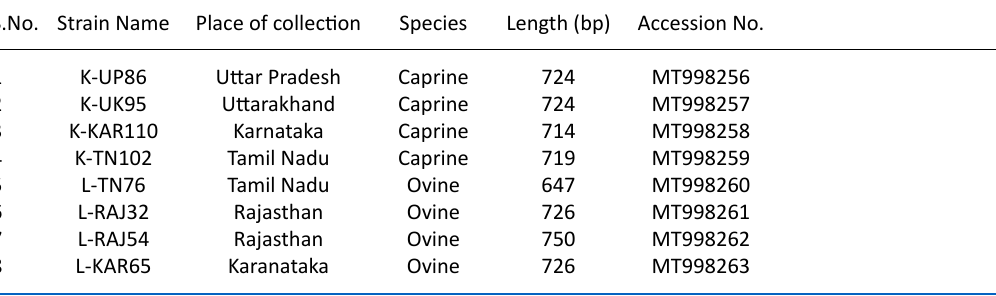
Table 2. Randomly selected isolates from different states of Northern and Southern India were submitted in the NCBI GenBank